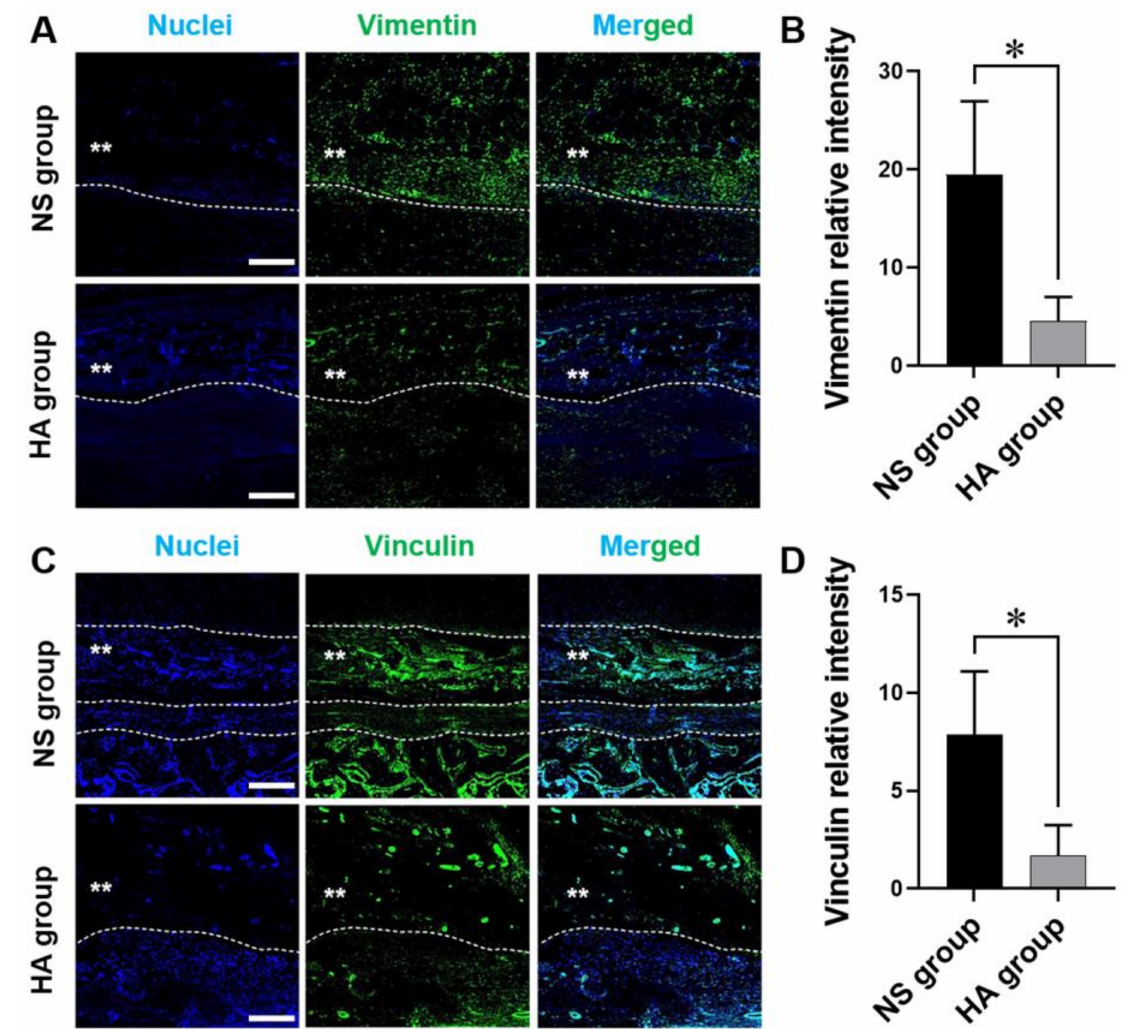
Figure 5. Immunofluorescence staining of vimentin and vinculin and image analyses at 10 weeks after surgery. ( A , C ) Im- munofluorescence staining of vimentin ( A , green), vinculin ( C , green), and cell nuclei (blue); merged images are shown as separate channels. The dashed line indicates the boundary between the tendon and peritendinous adhesion tissue. Scale bar = 200 µ m. ( B , D ) Immunofluorescence staining is quantified using ImageJ. The y-axis shows the mean intensity of immunofluorescence staining. The fluorescence intensities of vimentin ( B ) and vinculin ( D ) are significantly lower in the HA group than in the NS group (both, * p < 0.05). Values represent the means ± standard error of the mean (SEM). ( n = 12 for each